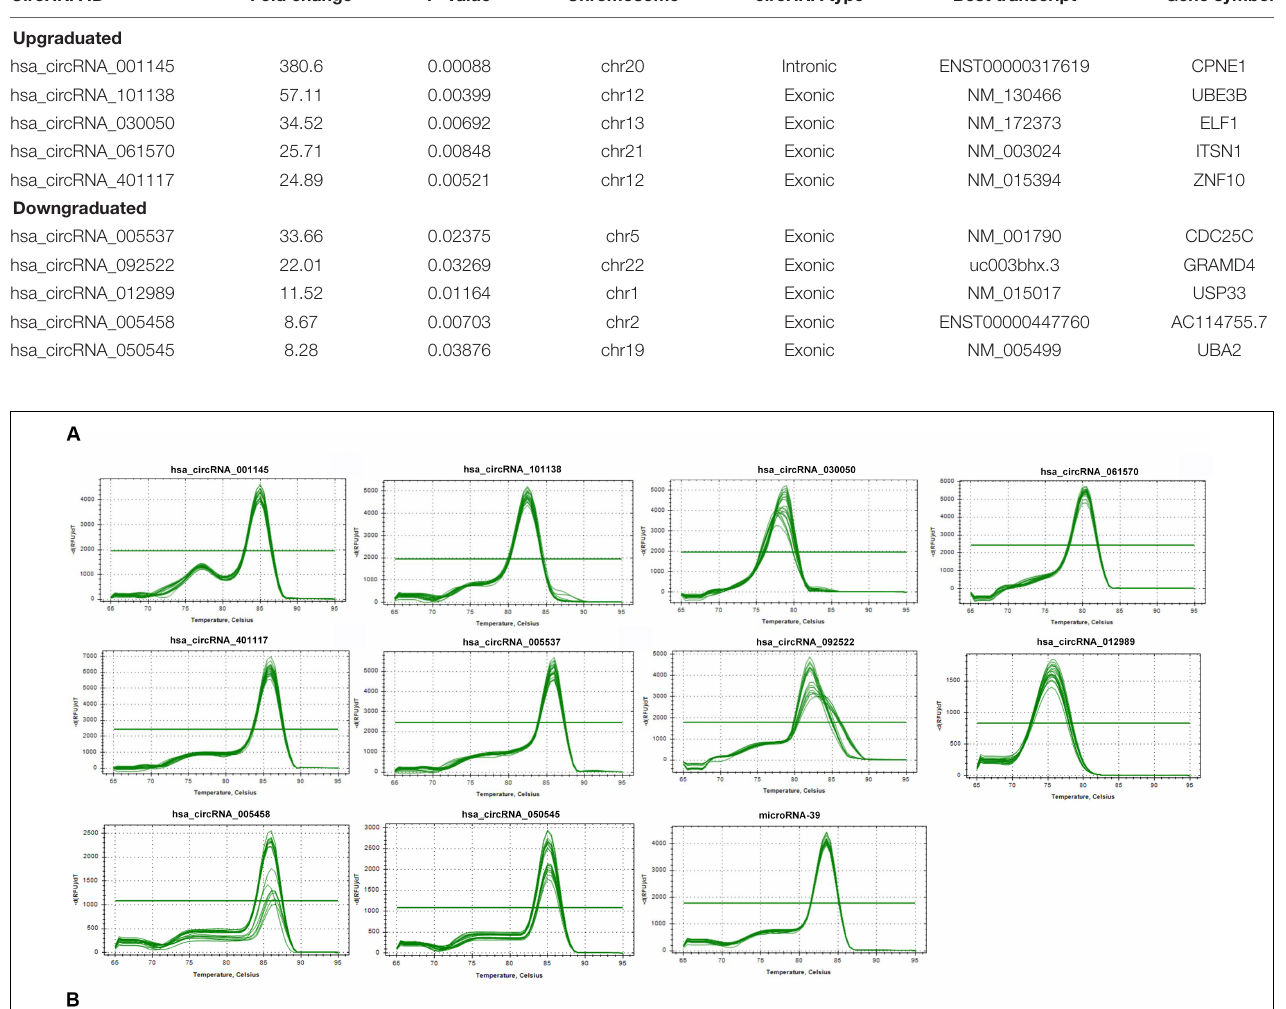
Frontiers in Aging Neuroscience |